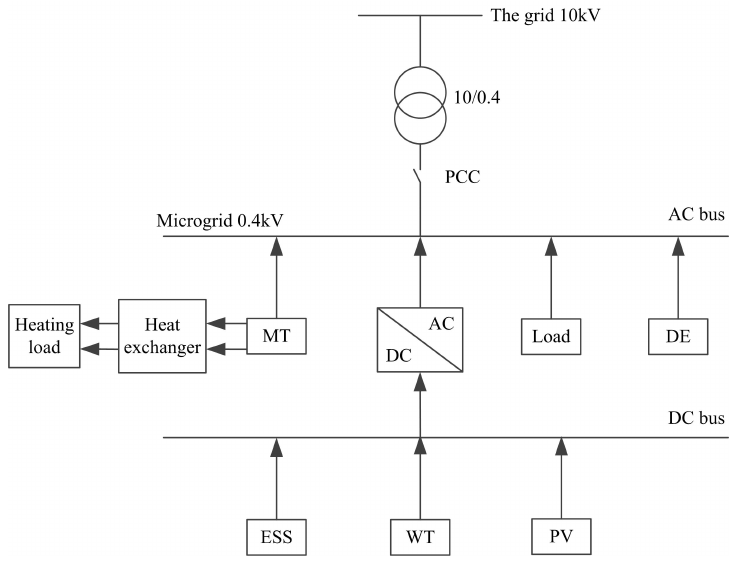
Figure 3. A microgrid system structure diagram.